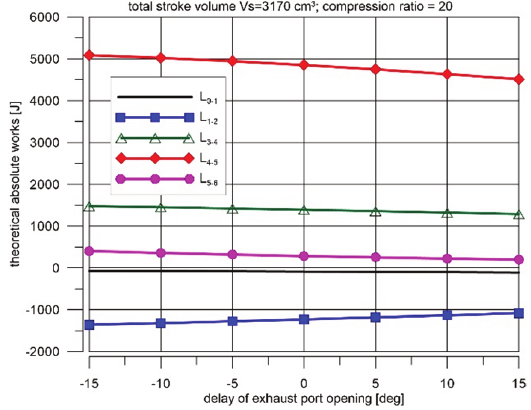
Fig. 8. Theoretical absolute works done during individual thermodynamic processes in a function of delay of opening of exhaust ports